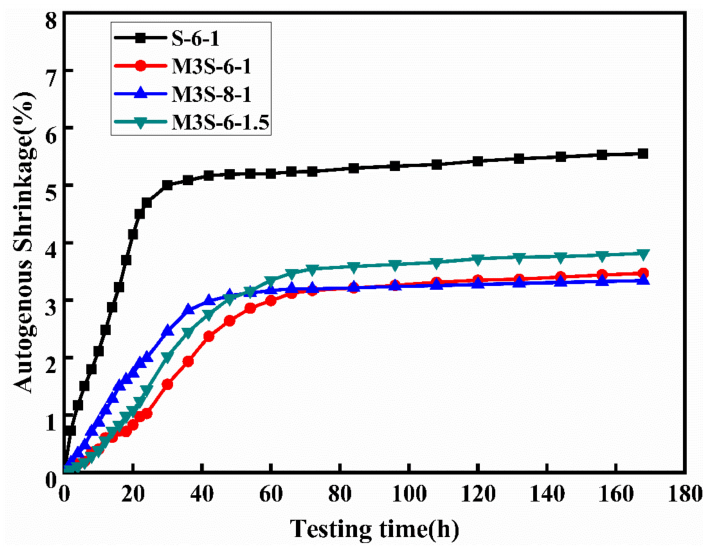
Figure 9. Effects of activator concentration and modulus on the autogenous shrinkage of alkali-activated slag mortar with 30% metakaolin.